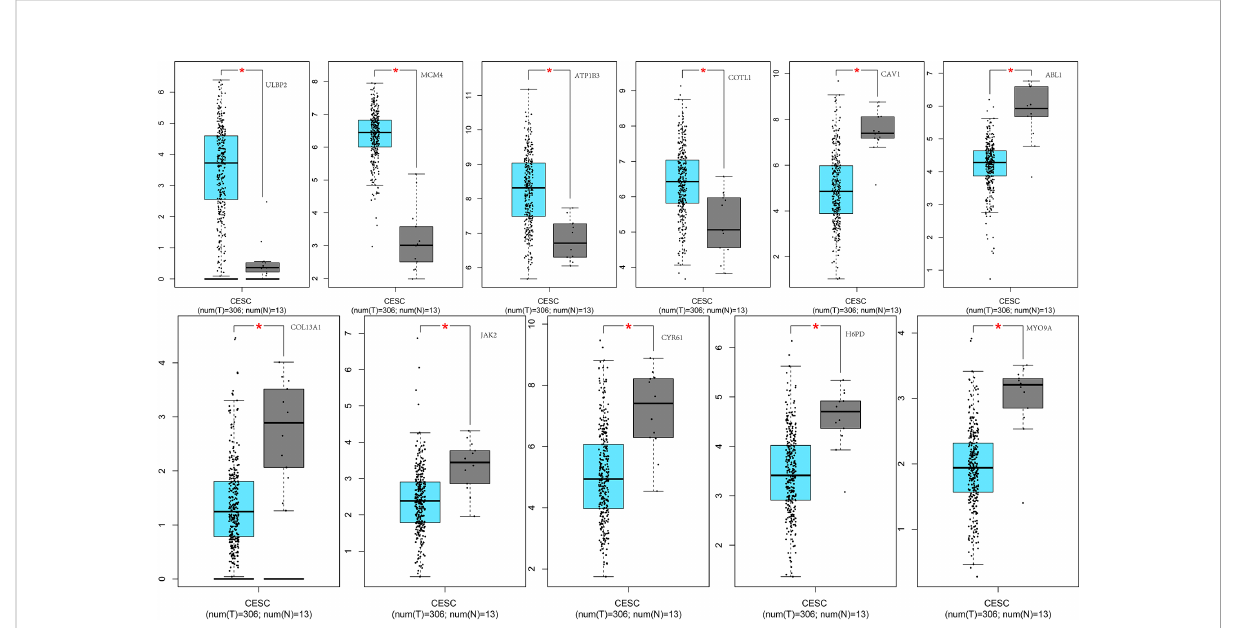
FIGURE 9 Differential expression of ceRNAs between the two groups of samples. From left to right: the 1st row shows differential expression of ULBP2, MCM4, ATP1B3, COTL1, CAV1, ABL1 between the two groups of samples; the 2nd row displays differential expression of COL13A1, JAK2, CYR61, H6PD, MYO9A, between the two groups of samples.